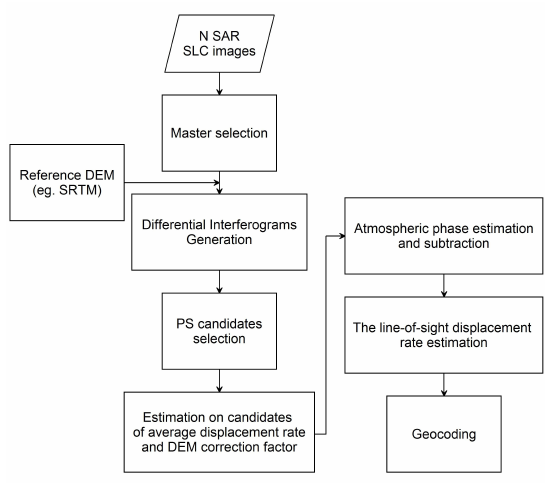
Figure 1. PS-InSAR data processing workflow